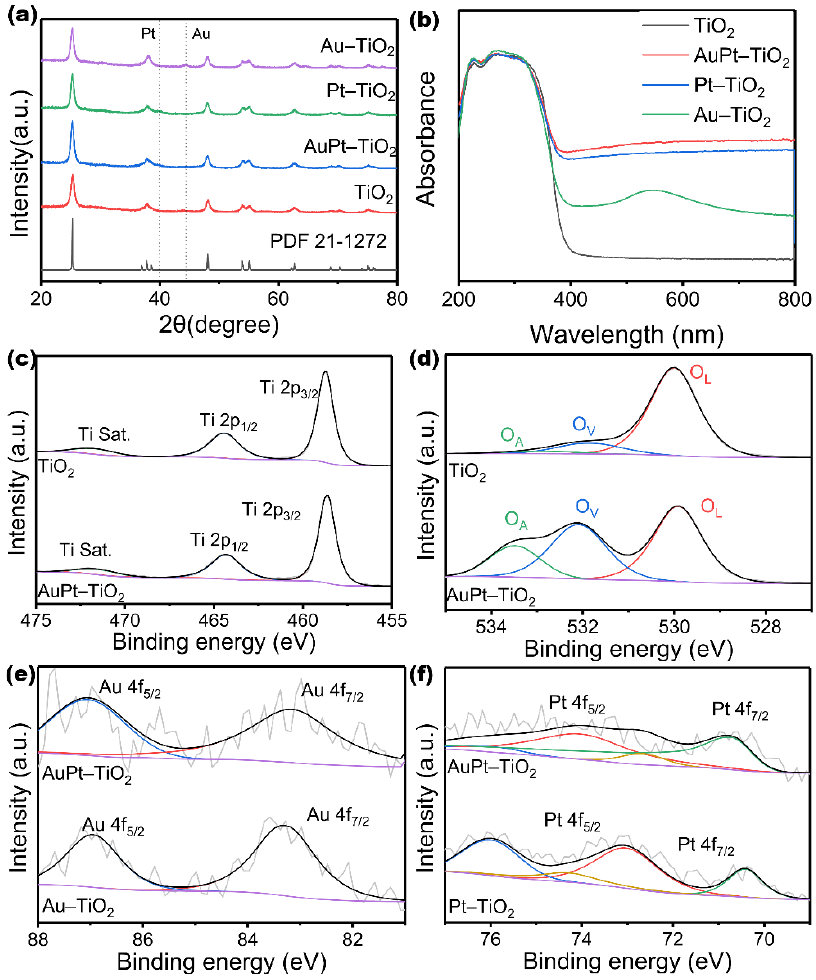
Figure 2. ( a ) XRD patterns and ( b ) UV – vis spectra of TiO 2 MSs, AuPtTiO 2 , Pt – TiO 2 and Au – TiO 2 . ( c ) Ti 2p and ( d ) O 1s of TiO 2 MSs and AuPt – TiO 2 , ( e ) Au 4f of AuPt – TiO 2 and Au – TiO 2 and ( f ) Pt 4f XPS spectra of AuPt – TiO 2 and Pt – TiO 2 .